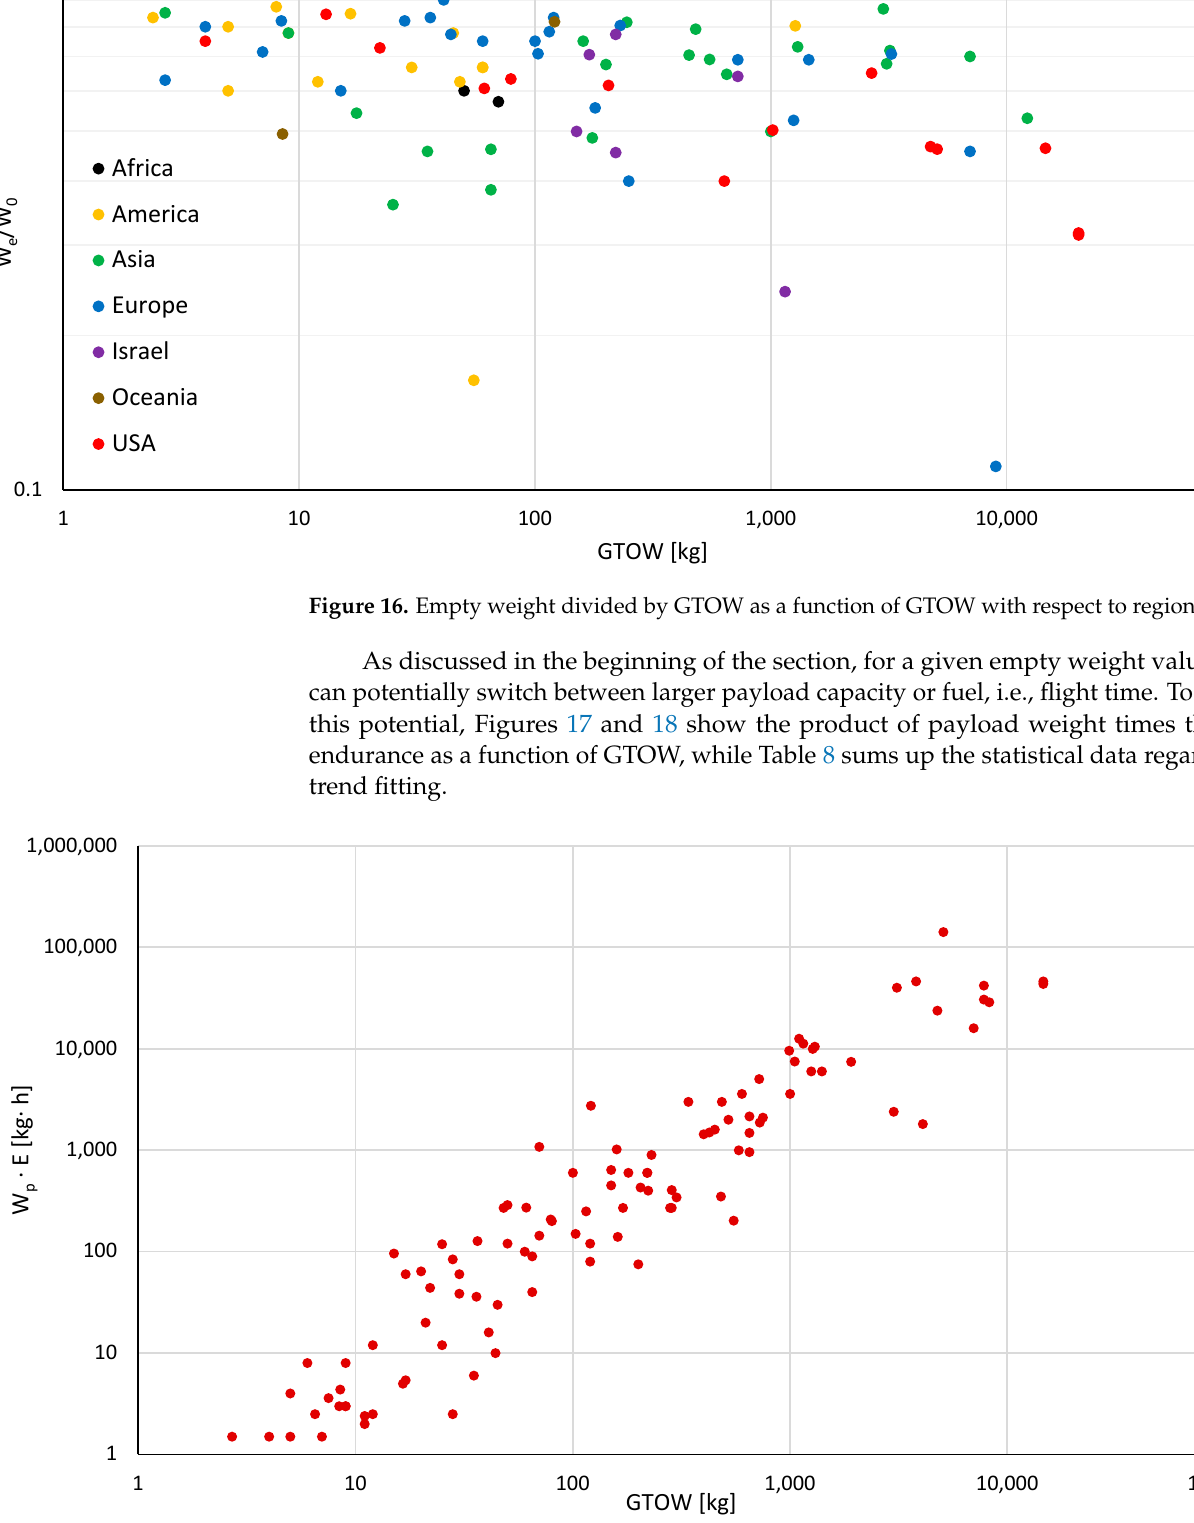
Figure 17. W p · E as a function of GTOW.